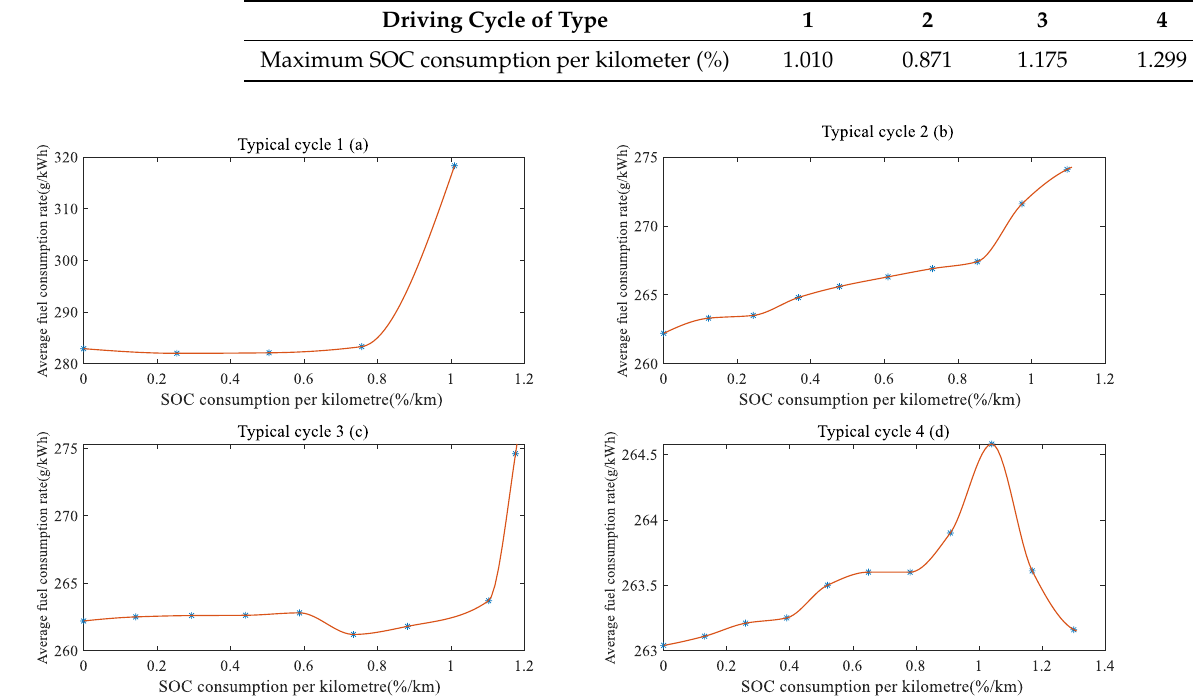
Figure 9. Relationship curve between SOC consumption per kilometer and the average fuel consumption rate under four typical cycles. ( a ) typical cycle 1; ( b ) typical cycle 2; ( c ) typical cycle 3; ( d ) typical cycle 4.